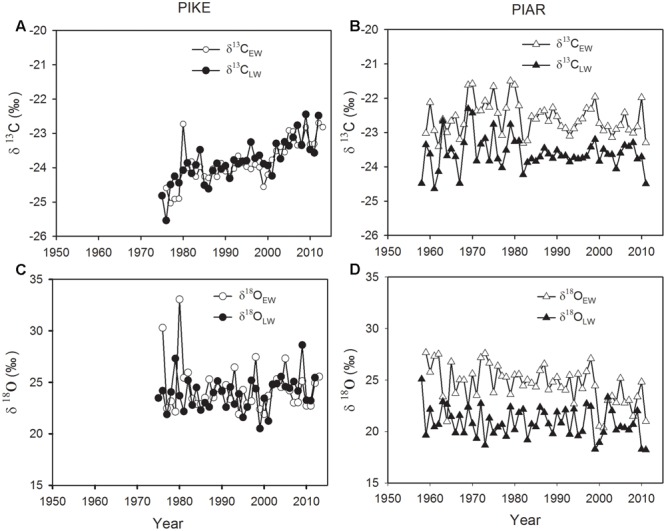
Carbon isotope variations in earlywood (δ13CEW, open circle) and latewood (δ13CLW, closed circle) of secondary forest pine P. kesiya (PIKE, A) and in earlywood (δ13CEW open triangle) and latewood (δ13CLW, closed triangle) of P. armandii (PIAR, B), and oxygen isotope variations in earlywood (δ18OEW, open circle) and latewood (δ18OLW, closed circle) of P. kesiya
(C) and in earlywood (δ18OEW, open triangle) and latewood (δ18OEW, closed triangle) of forest pine P. armandii
(D).